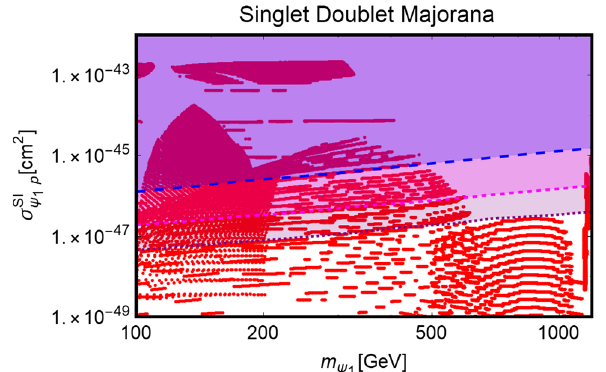
Fig. 28 Model points (red) with the correct DM relic density, emerg- ing from a scan on the M N , M L , y , θ parameters (see main text for details), in the bi-dimensional plane ( m ψ currently excluded by DD limits while the magenta and purple regions correspond to the expected future sensitivity reaches of XENON1T and LZ,